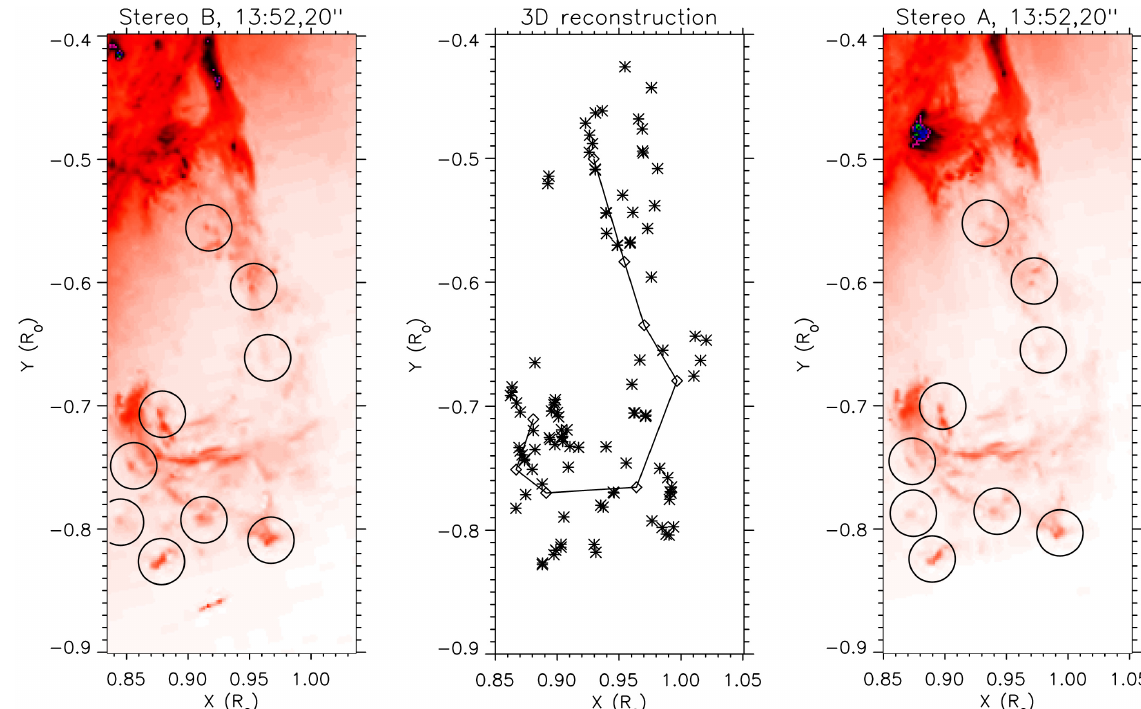
Fig. 2. The pair of He II λ 304 images acquired at 13:52 UT by EUVI aboard STEREO B (left panel) and A (right panel) and the 3-D positions (reconstructed via triangulation) of the 100 pairs of features selected inside the prominence as seen from the Earth (middle panel). As an example, some of the selected pairs are outlined in left and right panels by white solid